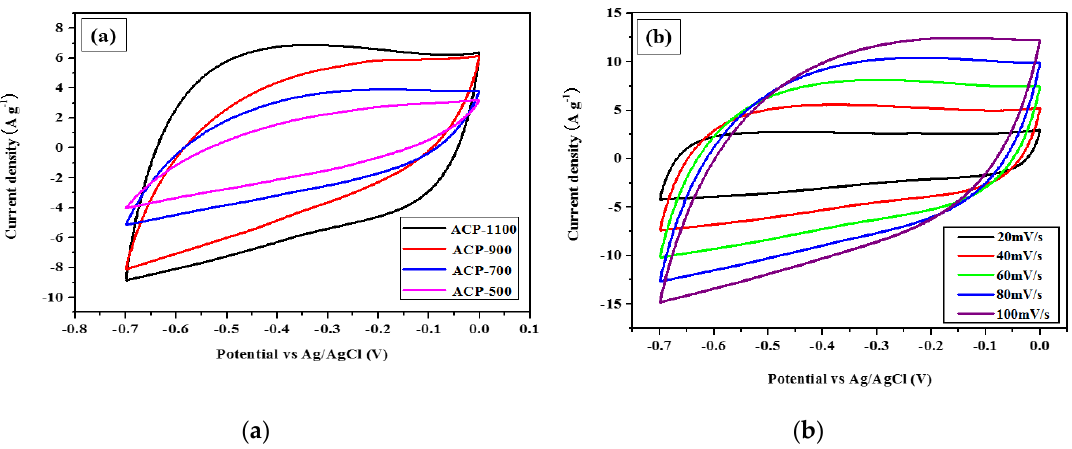
Figure 4. Electrochemical performance in 1 mol L − 1 KOH: ( a ) cyclic voltammograms of ACP-500, ACP-700, ACP-900, and ACP-1100 electrodes, scan rate: 50 mVs − 1 and ( b ) cyclic voltammograms of ACP-1100 electrode, with various scan rates between 10 and 100 mVs − 1